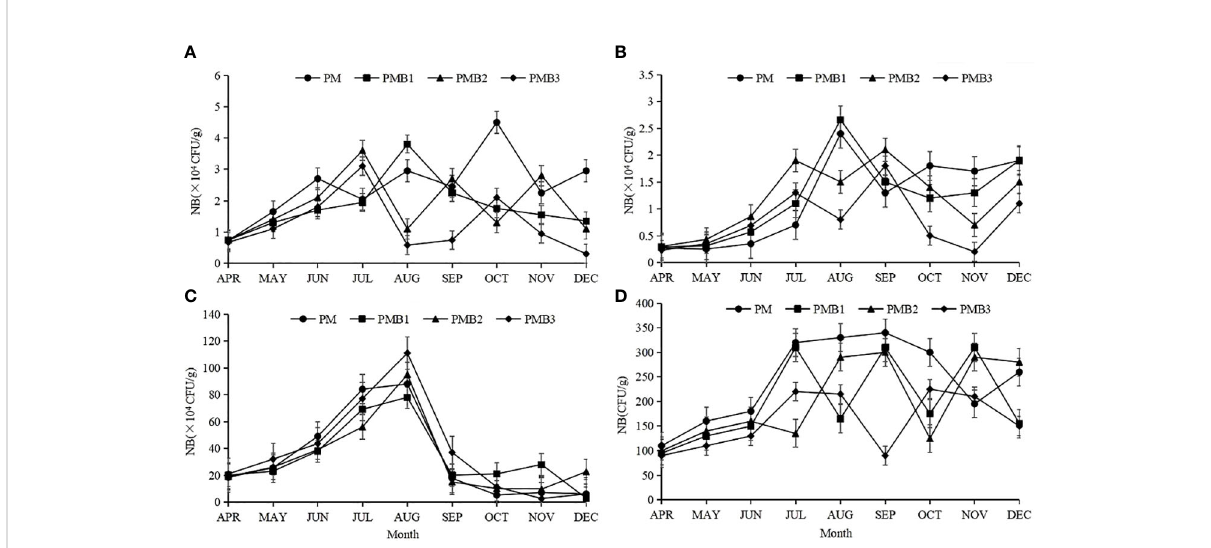
FIGURE 2 Changes in the number of functional bacteria in sediment during the farming period. The data are shown as the means ± SDs. (A) , the number of starch-degrading bacteria; (B) , the number of lipid-degrading bacteria; (C) , the number of cellulose-decomposing bacteria; (D) , the number of glutin-degrading